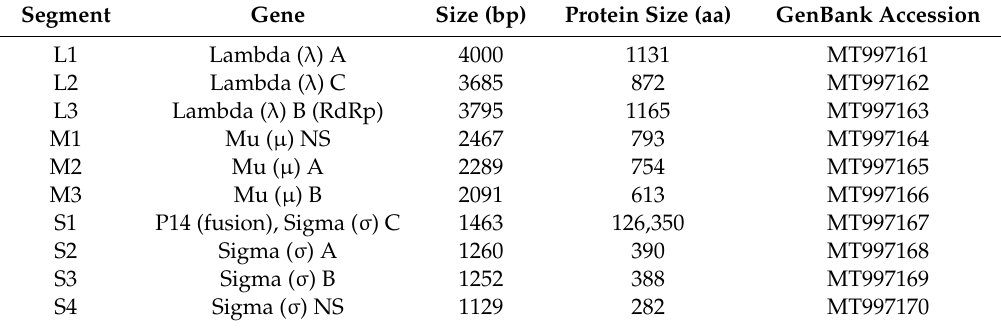
Figure 5. Phylogenetic tree of veiled chameleon serpentoviruses and other reptilian serpentoviruses. The entirety of ORF1b amino acid sequences were aligned and a phylogenetic tree constructed. Veiled chameleon serpentoviruses (VCSV-A and VCSV-B; light green) were compared to known serpentoviruses found in snakes (ball python, Indian python, Morelia viridis , Guangdong snake nidoviruses/toroviruses; blue), lizards (shingleback nidovirus; dark green), turtles (Bellinger river virus; red), and snake-associated nematodes (Xinzhou viruses; orange) as well as a remotovirus (bovine nidovirus; black) of the same Tobaniviridae family. GenBank accession numbers are included to the right of the virus name. Maximum likelihood tree constructed using PhyML, LG substitution model, and 1000 bootstrap replicates; bootstrap values (percent) represented at each node. Bovine nidovirus outgroup. Table 3. General features of the veiled chameleon orthoreovirus genome. The long (L), medium (M), and short (S) encoded genes are indicated. The nucleotide length of each segment is indicated, as is the amino acid length of the encoded